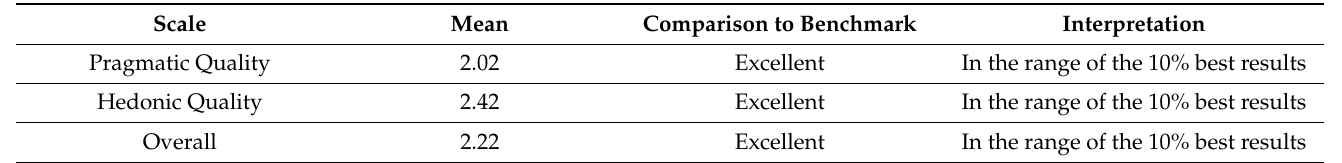
Table 4. Benchmark results for engineers’ responses to the UEQ-S.